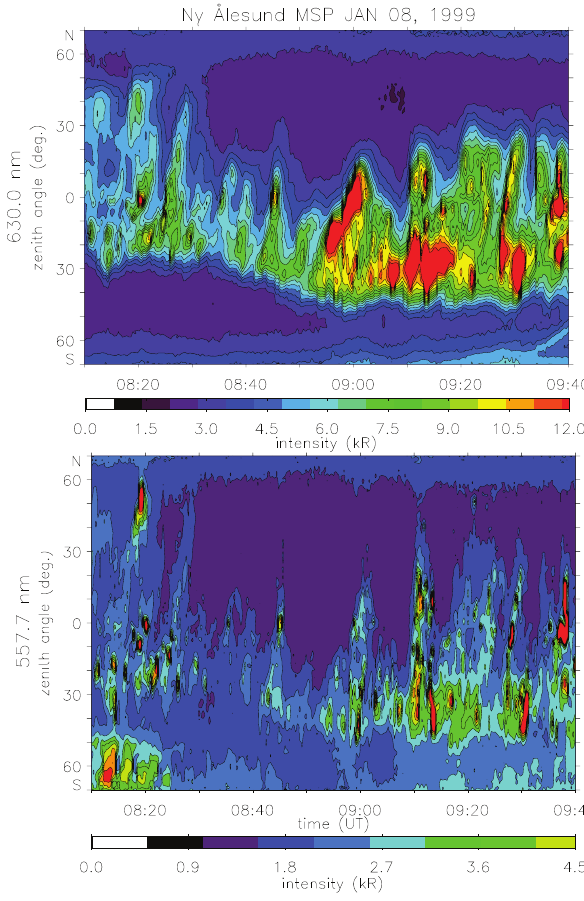
Fig. 16. Ny ˚Alesund MSP data for the interval 08:10–09:40UT. The red and the green line emissons are shown in the upper and lower panels, respectively. Times of SuperDARN plasma convec- tion data shown in this study are indicated by vertical guidelines. Same format as in Fig.